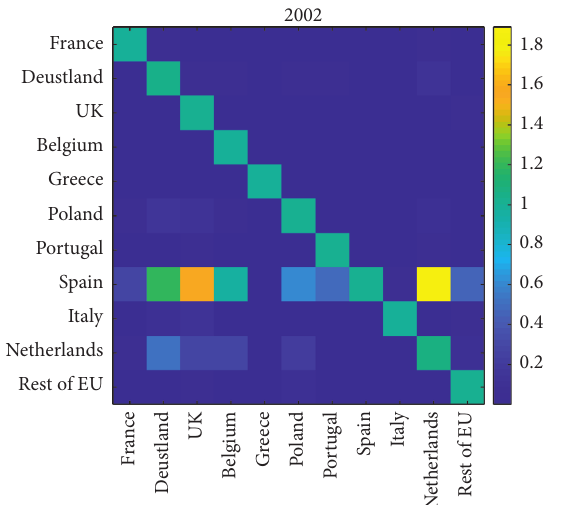
Figure 3: Triangulation of inverse matrix 2007. Source: own